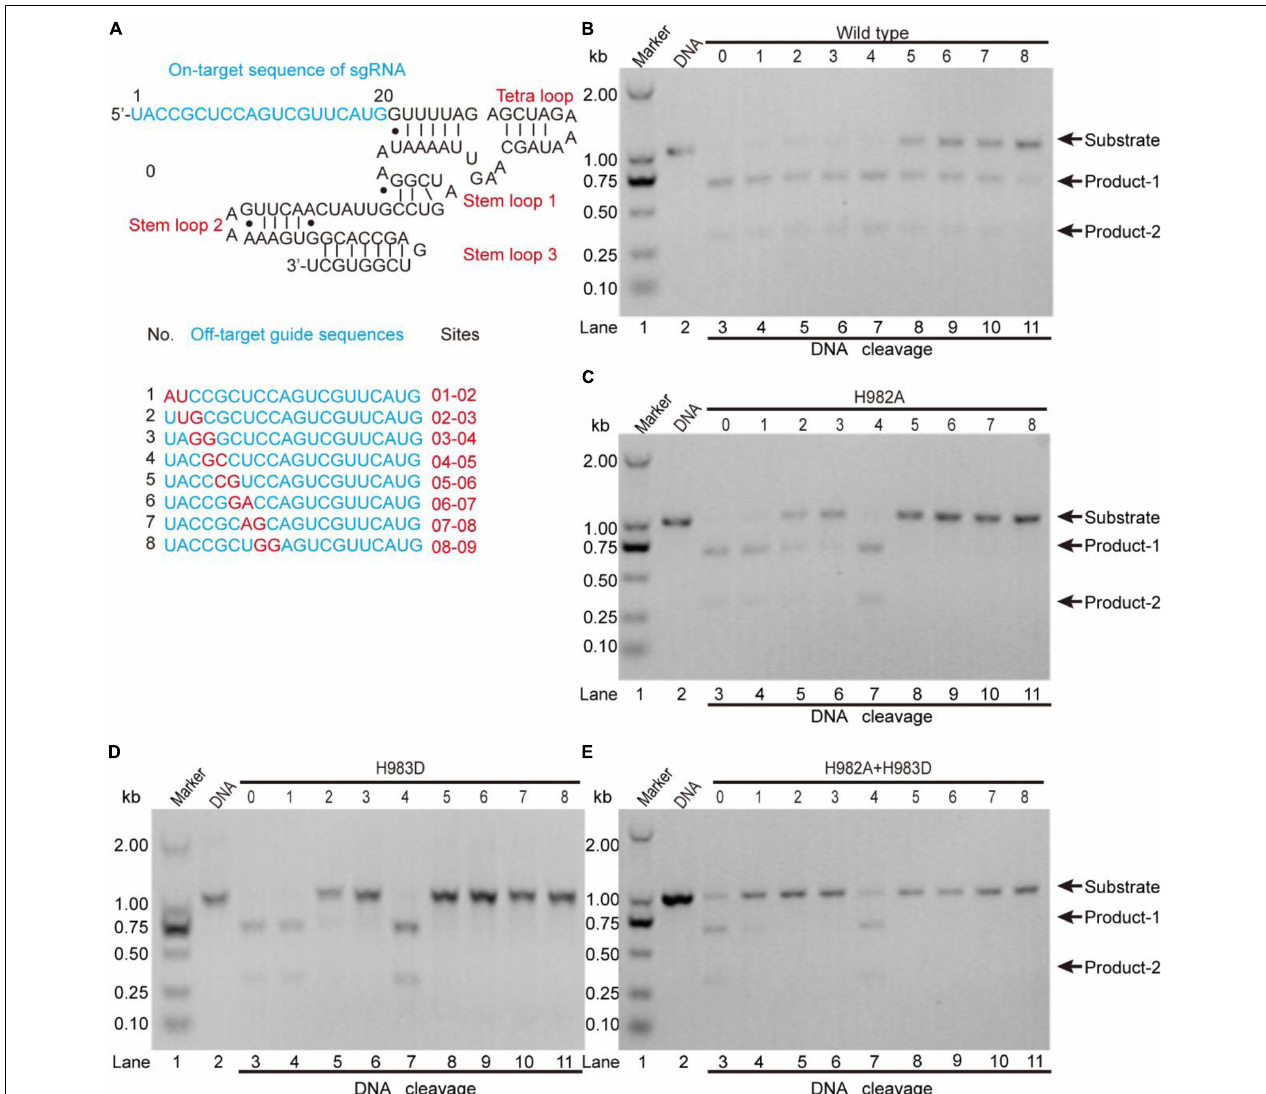
FIGURE 5 | The detection of the in vitro off-target effects. (A) The sequences of the sgRNA and its mutants. The on-target sequence of the sgRNA shows in No. 0; the off-target sequences show in Nos. 1, 2, 3, 4, 5, 6, 7, and 8. (B–E) The detection of the off-target effects for the wild-type SpCas9 and its mutants. The target DNA molecules are cleaved into two products (product-1 and